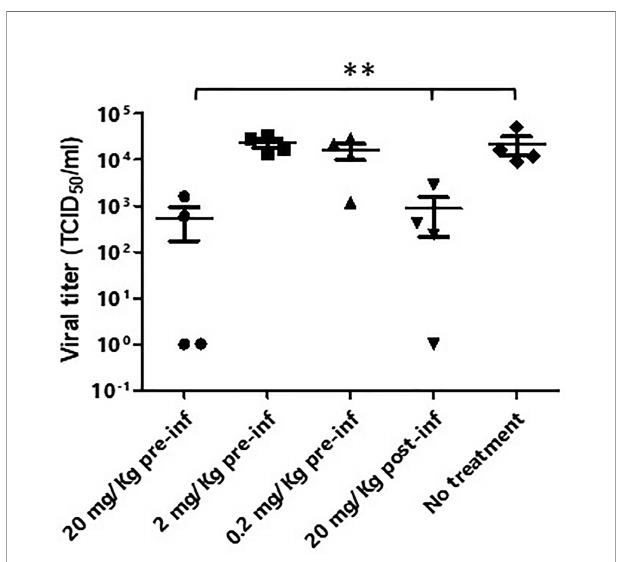
FIGURE 5 | Murine model of SARS-CoV-2 infection. Balb/c mice (n=4/group) were fi rst transduced intranasally with adenovirus coding for human ACE-2. After 5 days, mice were infected intranasally with SARS-CoV-2 (Wuhan strain) and received the indicated dose of XAV-19, intraperitoneally, 24 h before (pre- inf) or after (post-inf) infection. Three days later, lungs were necropsied and homogenized and the viral load was evaluated by PRNT. Each dot represents a single mouse and is the mean of eight replicates assessed in a single experiment. Nonparametric statistics were used for pairwise comparisons using Kruskal – Wallis tests. **p <